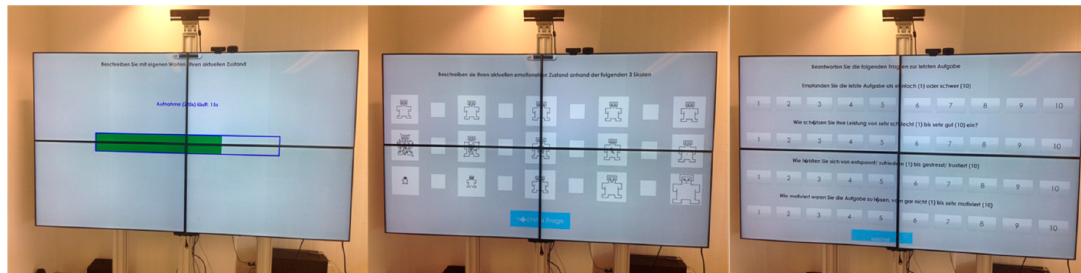
Figure 2. Illustration of the subjective feedback screens including Free Speech ( left ), SAM Ratings ( middle ) and Direct Questions ( right ) parts. Note that the SAM Ratings are scored on a nine-point Likert scale (represented by both the big labeled fields and the small empty fields).